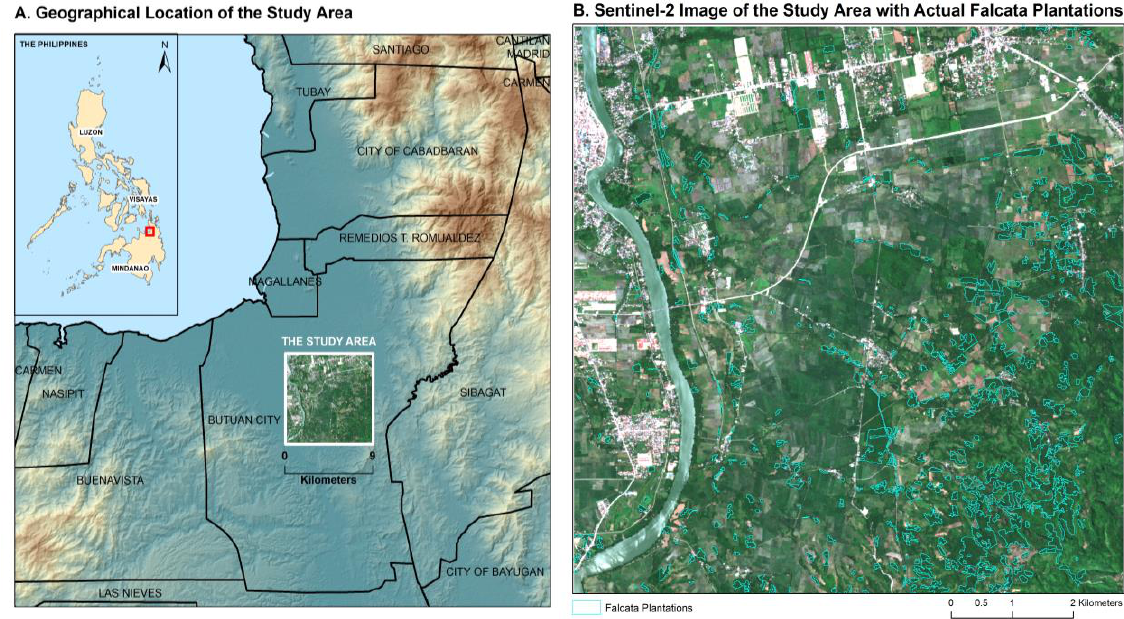
Figure 1. The study area in Butuan City, Agusan del Norte, Mindanao, Philippines, shown together with the 10-meter resolution, true color Sentinel-2